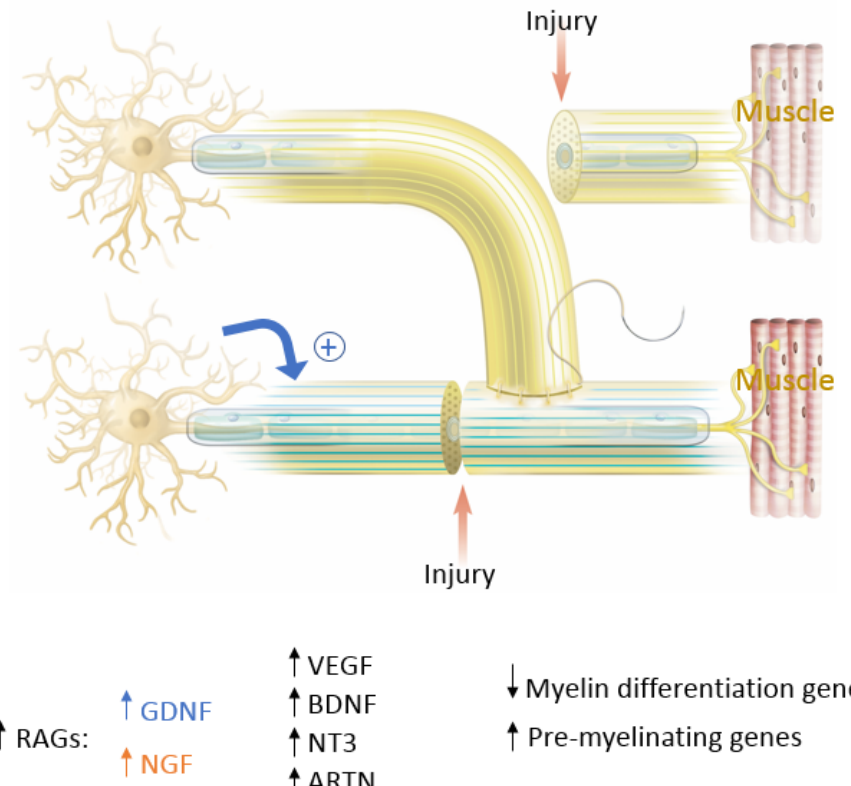
Figure 4. The key molecular players in peripheral nerve regeneration. In blue are factors that favor End-To-End (ETE) repair and in orange are factors that favor End-To-Side (ETS) repair. Factors that favor both ETE and ETS repair are in black. RAGs= Regeneration Associated Genes; GDNF = Glial Derived Neurotrophic Factor; NGF = Nerve Growth Factor; VEGF = Vascular Endothelial Growth Factor; BDNF = Brain-Derived Neurotropic Factor; NT3 = Neurotrophin-3; ARTN = Artemin.